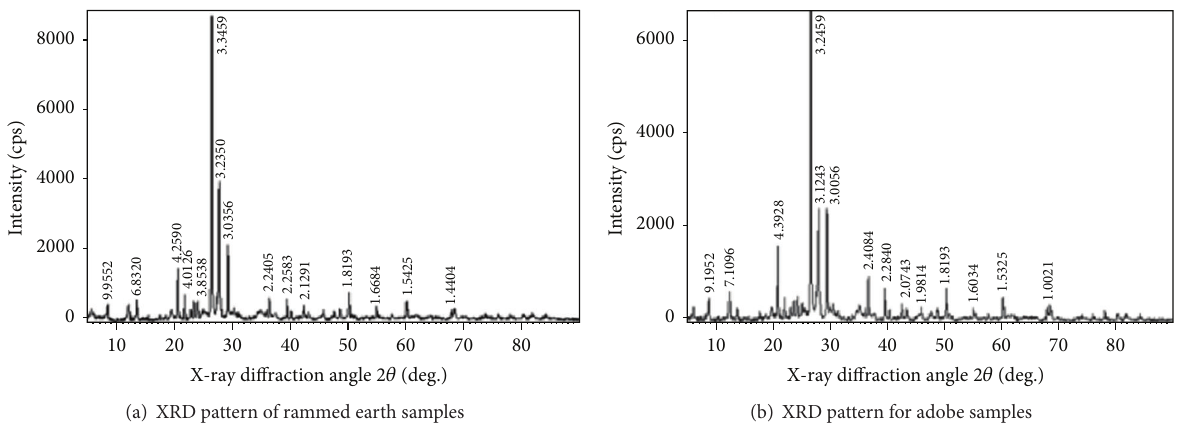
Figure 2: X-ray diffraction analysis results (test condition: 40 kV, 35 mA; scan type: continuous; temperature: 25 ∘ C; and anode material: Cu).